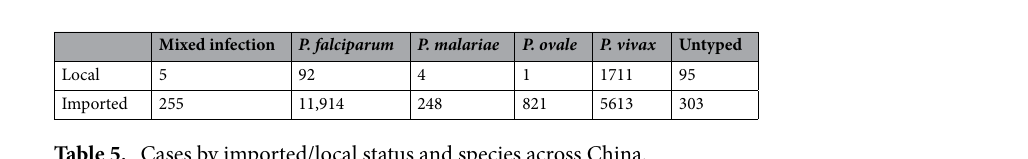
Table 5. Cases by imported/local status and species across China.